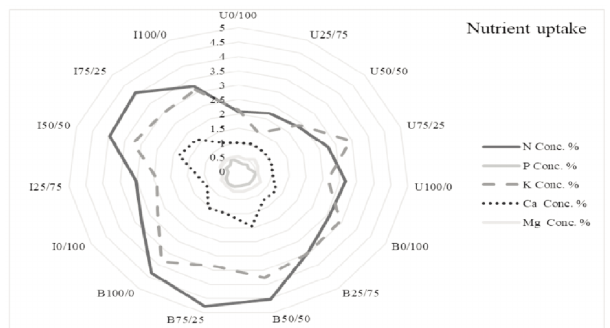
Fig. 7 ­ The effects of different rootstocks on nutrients (N, P, K, Ca and Mg) absorption in different NO